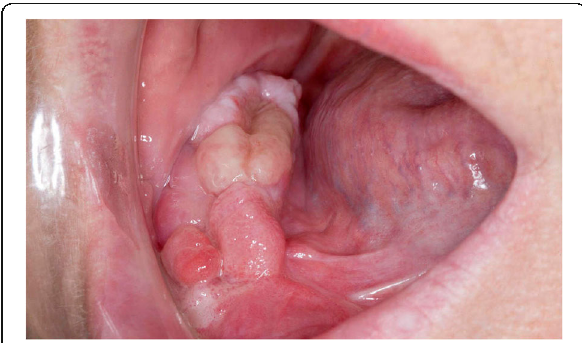
Fig. 3 Firm nodular gingival enlargement over the mandibular